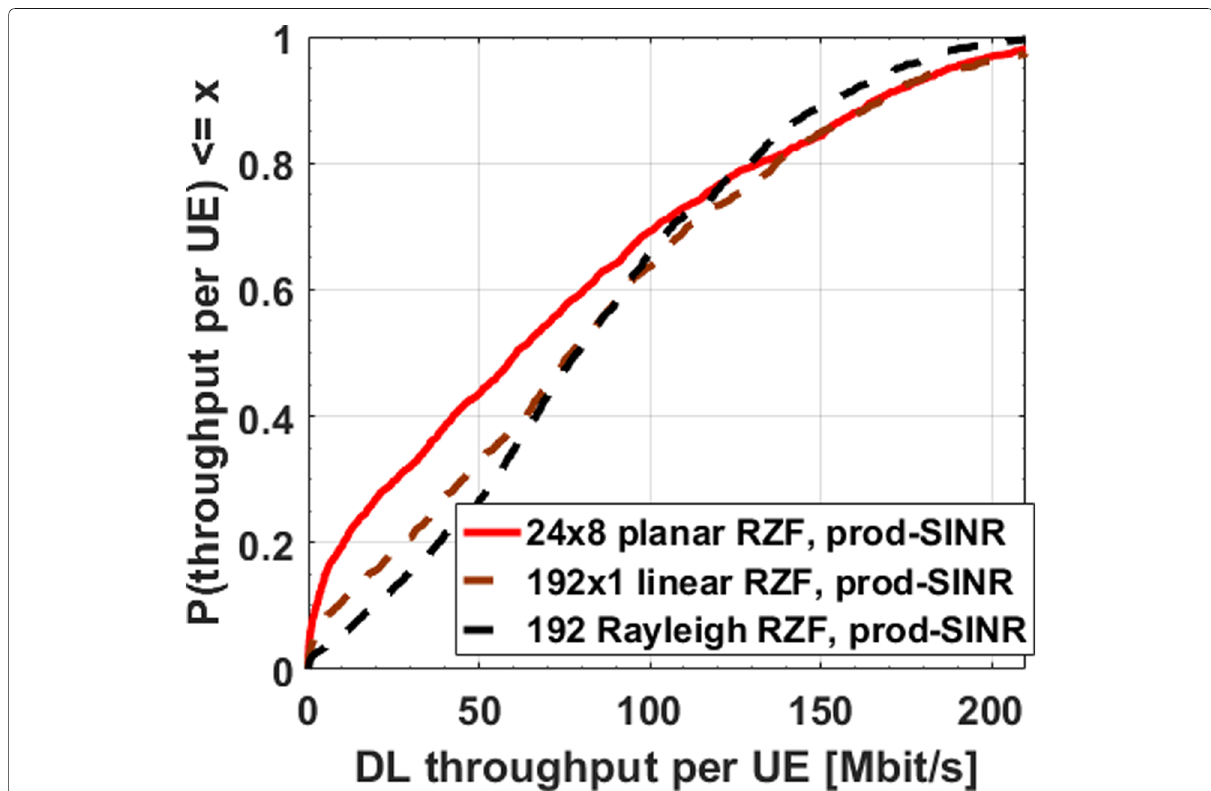
Fig. 11 DL throughput per UE for comparison of ray-based deterministic channel and i.i.d. Rayleigh based channel as applied to system-level